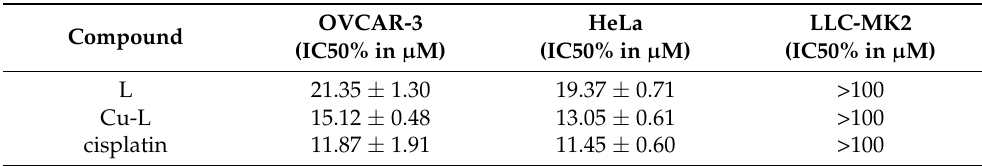
Table 3. Anticancer activities of L, Cu-L, and cisplatin in DMSO solutions.